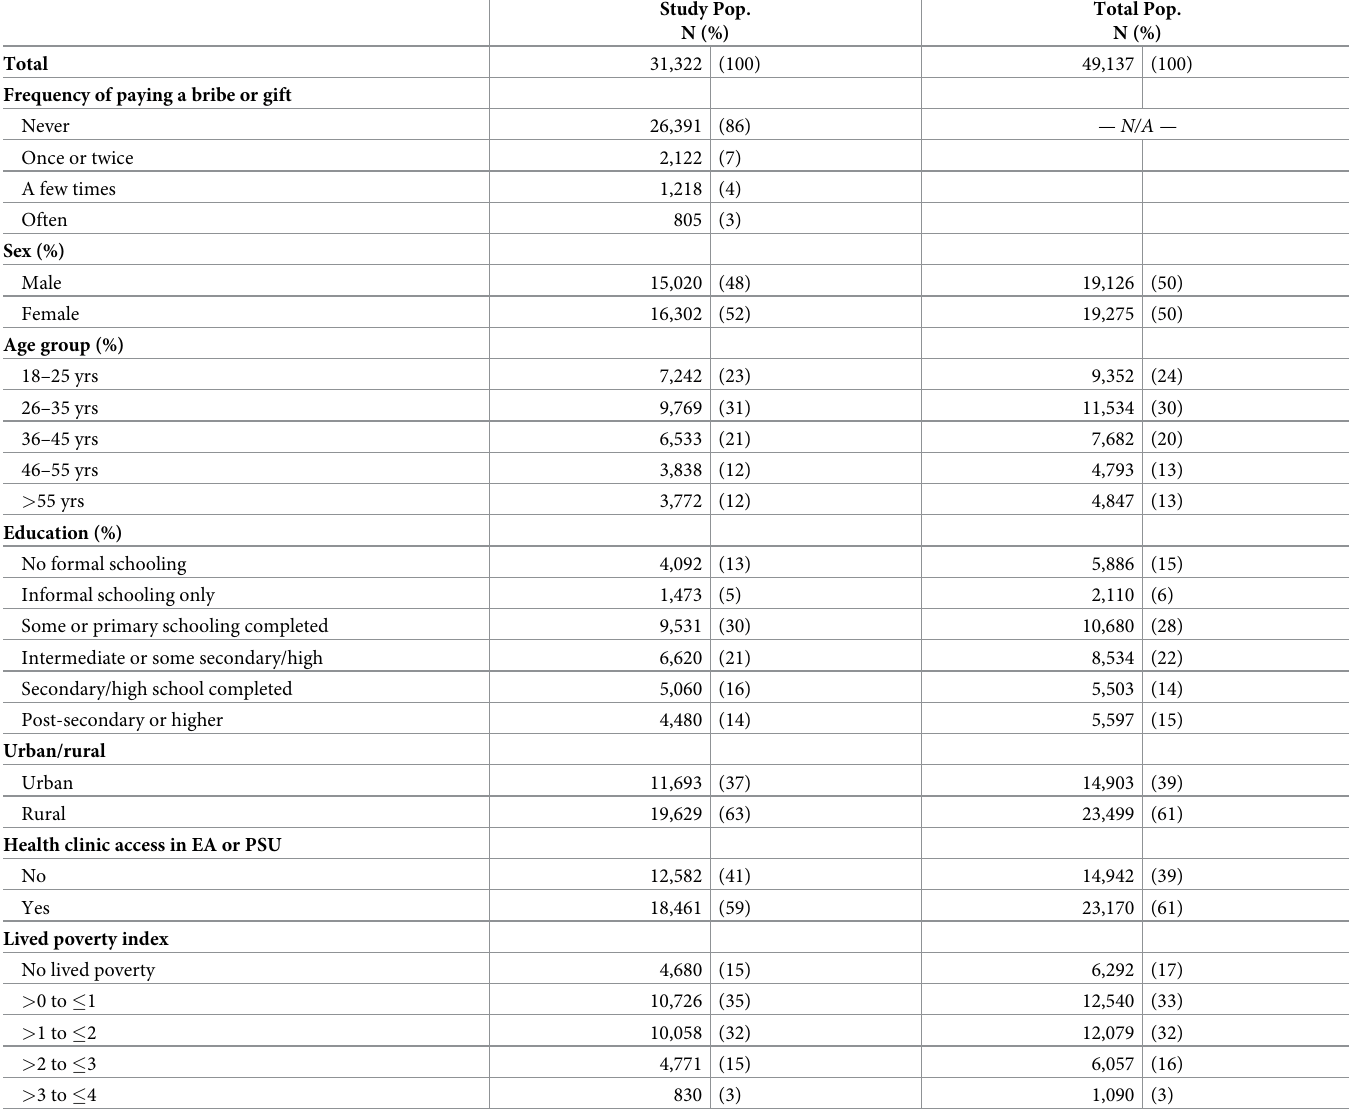
Table 1. Sociodemographic characteristics of study population vs. Afrobarometer total weighted population, 2014–2015 �